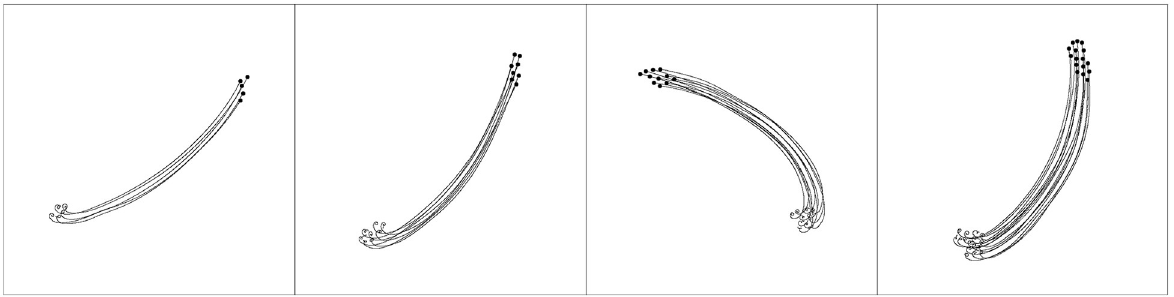
Fig 10. Example of the behaviour displayed by the highest-performing controller of the No Alignment setup , with 5, 8, 11 and 16 robots, from left to right. The behaviour displayed is more cohesive than the one in Fig 6.